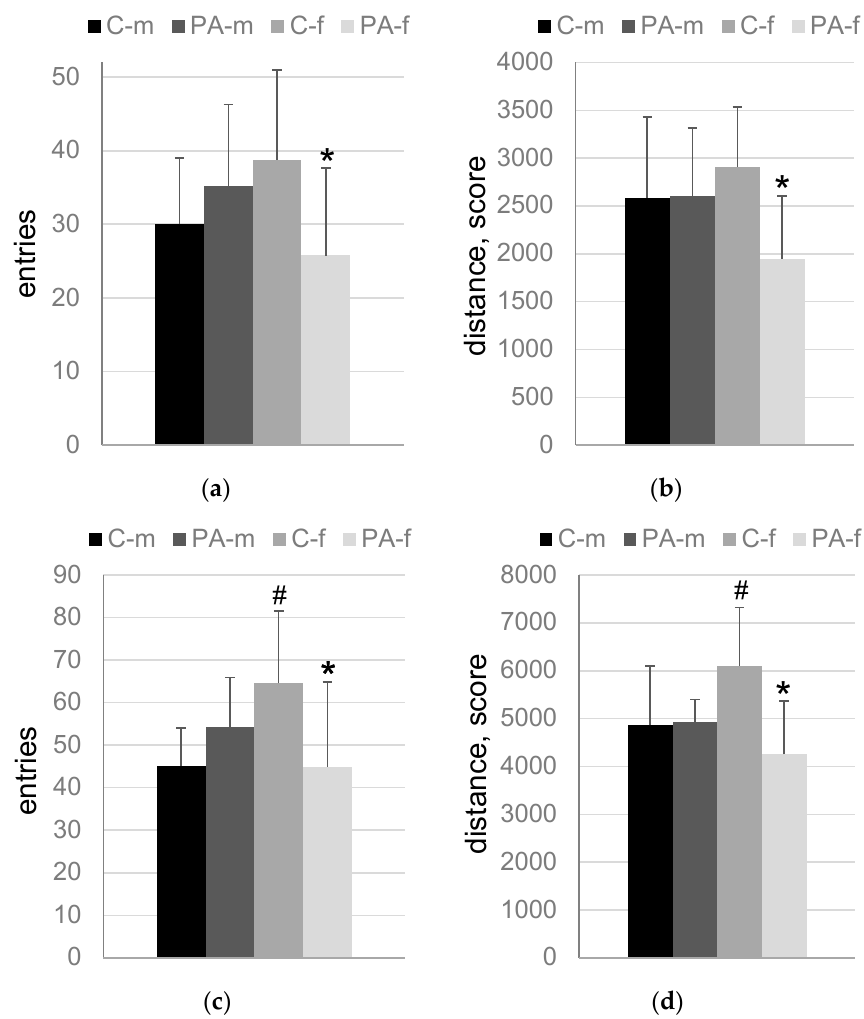
Figure 3. Light-dark box. Data present as mean + SD. ( a )—entries into the dark compartment; ( b )— distance in the dark compartment, scores; ( c )—entries into the middle compartment; ( d )—total distance travelled in all compartments, scores. C-m—male naïve rats, n = 9; PA-m—male PAE rats, n = 9; C-f—female naïve rats, n = 9; PA-f—female PAE rats, n = 9. Asterisk (*) indicates a significant difference between naïve and PAE rats of the same sex: *— p < 0.05; post hoc Duncan’s test. Hash (#) indicates a significant difference between groups of the same name of different sex: #— p < 0.05; post hoc Duncan’s test.